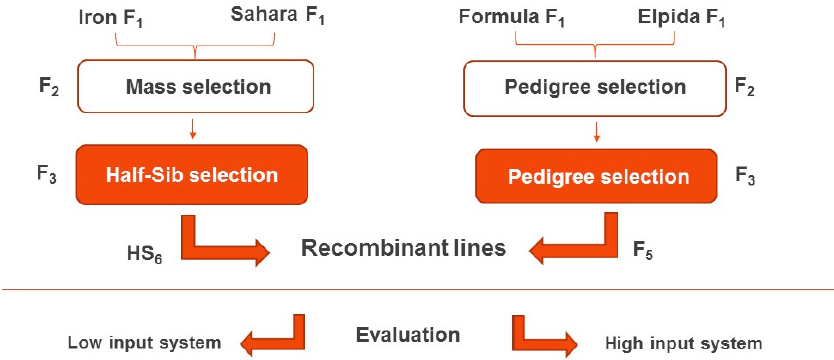
Figure 1. Breeding process applied for the production of new recombinant